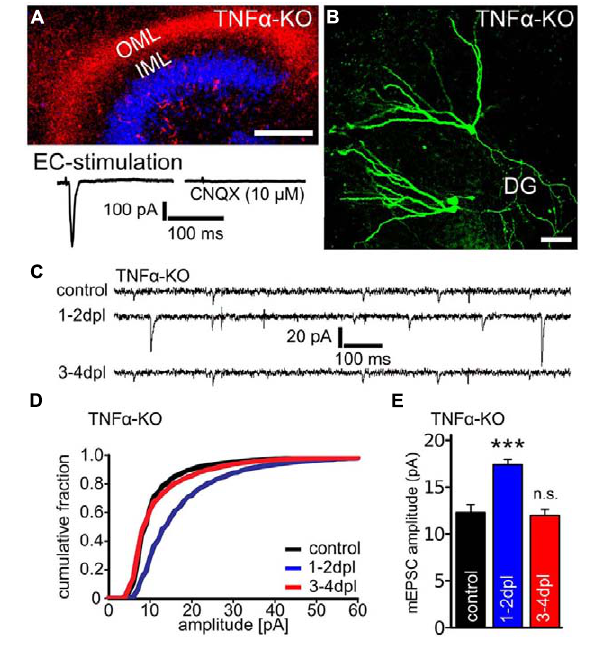
FIGURE 2 | Denervation-induced homeostatic synaptic strengthening is not observed in granule cells of TNF α -deficient slice cultures at 3–4 dpl. (A) Mini-Ruby tracing of entorhino-hippocampal axons (red; ToPRO nuclear staining, blue) and electrical stimulations of the entorhinal cortex (EC) while recording evoked EPSCs from dentate granule cells revealed an intact and functional entorhino-hippocampal projection in slice cultures prepared from TNF α -deficient mice (TNF α -KO; three independent experiments each, up to 50 traces averaged per neuron). Evoked EPSCs (amplitude: 369 ± 102 pA) could be blocked by the AMPA-receptor antagonist CNQX (10 μ M; amplitude: 9.6 ± 2.1 pA). Scale bar: 200 μ m. (B) Patched granule cells were filled with biocytin and post hoc identified using Alexa568- or Alexa488-streptavidin. Scale bar: 50 μ m. (C–E) Whole-cell patch-clamp recordings from granule cells of TNF α -deficient slice cultures revealed an increase in the mEPSC amplitudes at 1–2 dpl but not at 3–4 dpl ( n = 12–16 neurons per group, from six to eight cultures each). Data represent mean ±